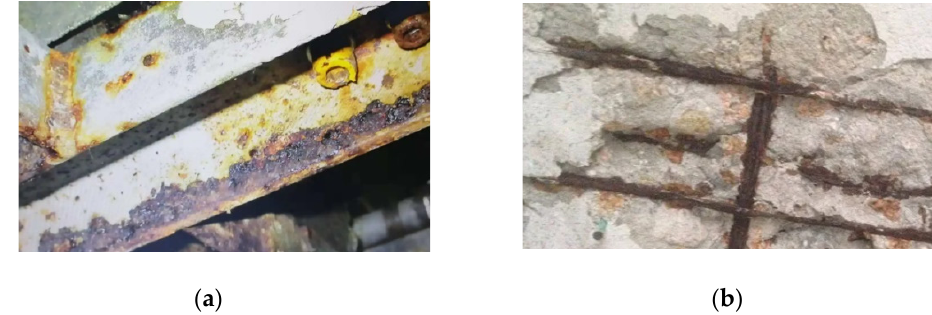
Figure 1. Corrosion in structural and reinforcing steels. ( a ) structural steel; ( b ) reinforcing steel.